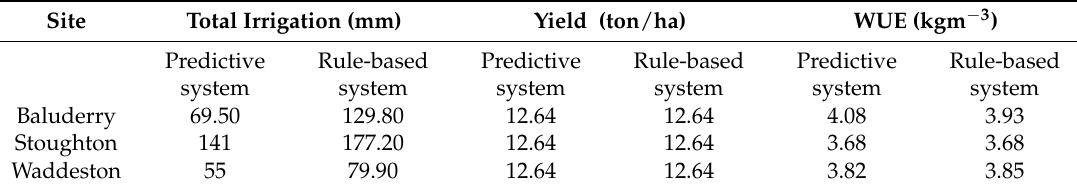
Table 8. Total irrigation application depth along with the simulated crop yield and water use efficiency for the potato growing